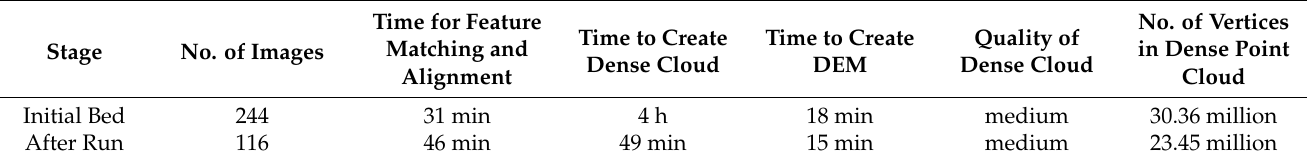
Table 1. Processing time and output quality for Case study I.